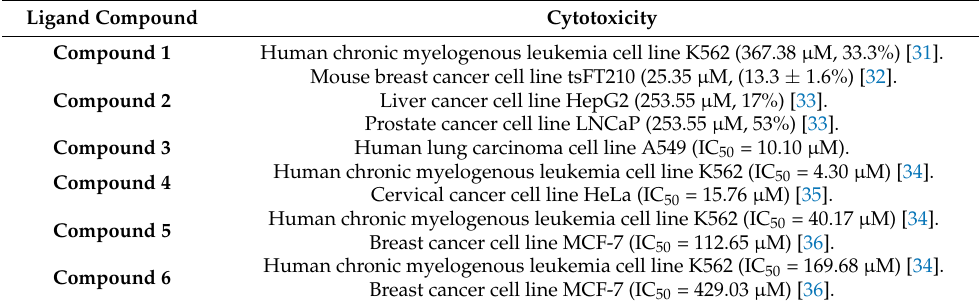
Table 2. Effects of ligand compounds on tumor